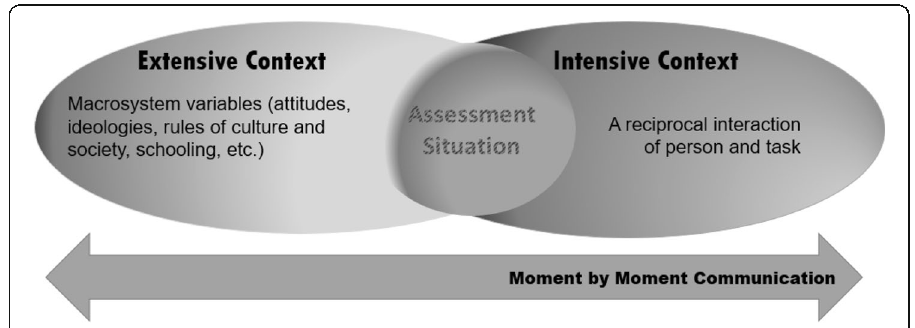
Fig. 1 Representations of context (an adaptation from Chalhoub-Deville 2009, p.